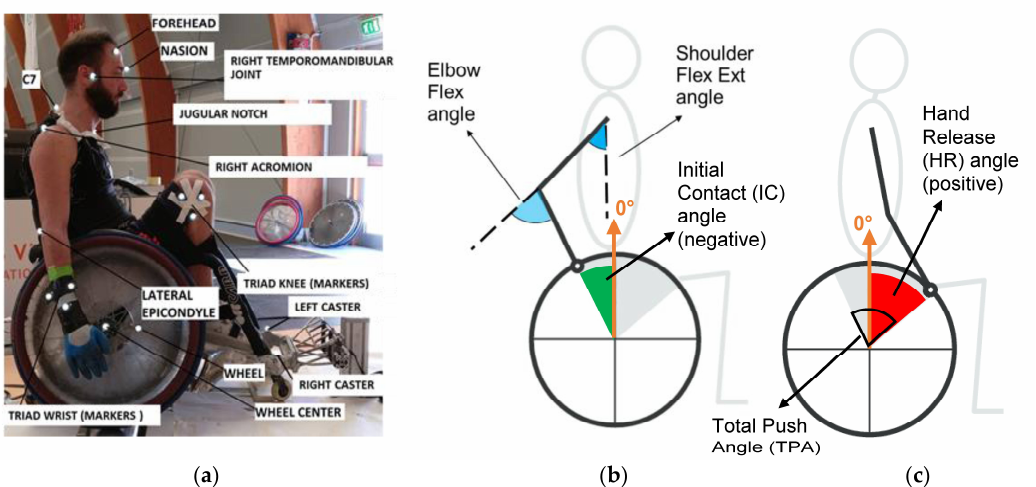
Figure 2. ( a ) Markers position on an athlete; ( b , c ) schematics of computed angles: flexion/extension angle for the shoulder, flexion angle for the elbow, the initial contact/hand release angles and the total push